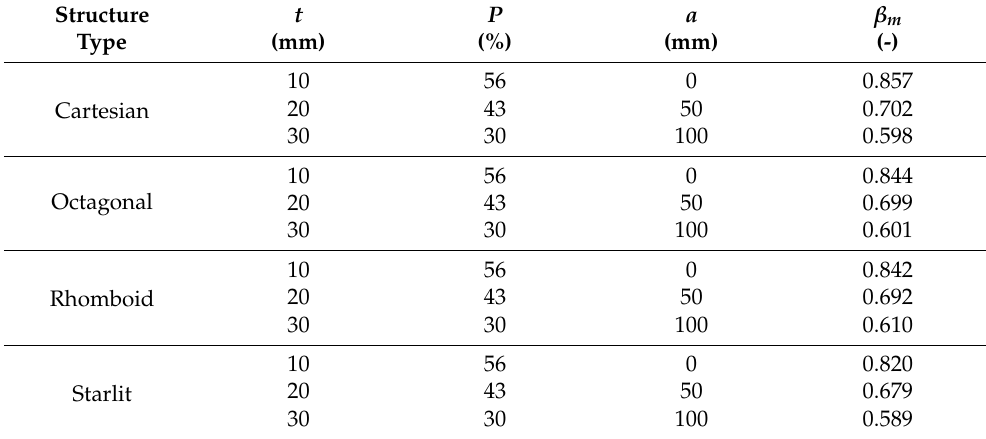
Table 4. Mean values of the sound reflection coefficient of selected 3D-printed open-porous PLA